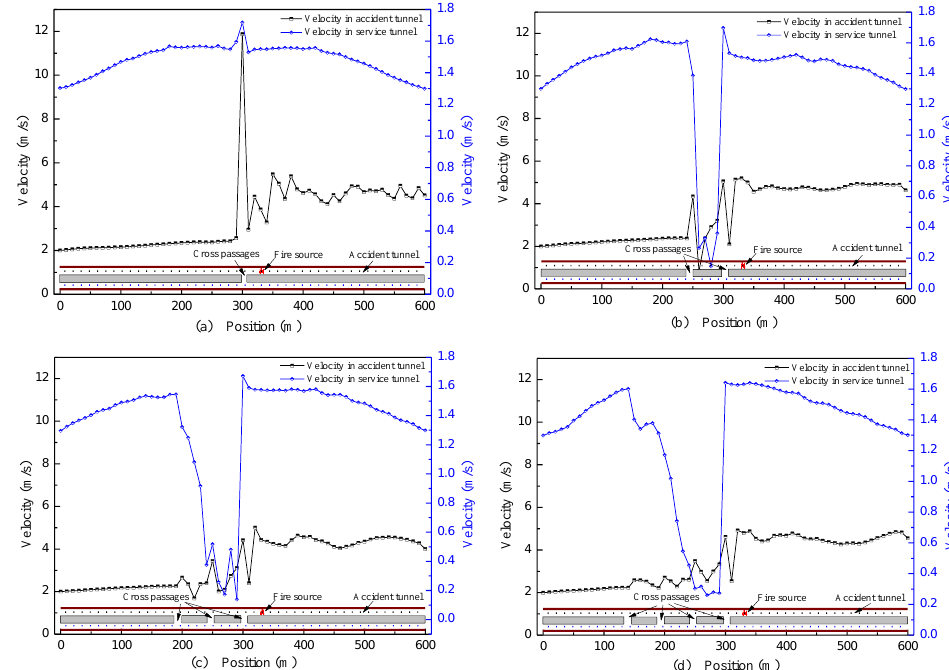
Figure 3. Velocity distribution with different numbers of cross passages open: ( a ) One cross passage open; ( b ) Two cross passages open; ( c ) Three cross passages open; ( d ) Four cross passages open.